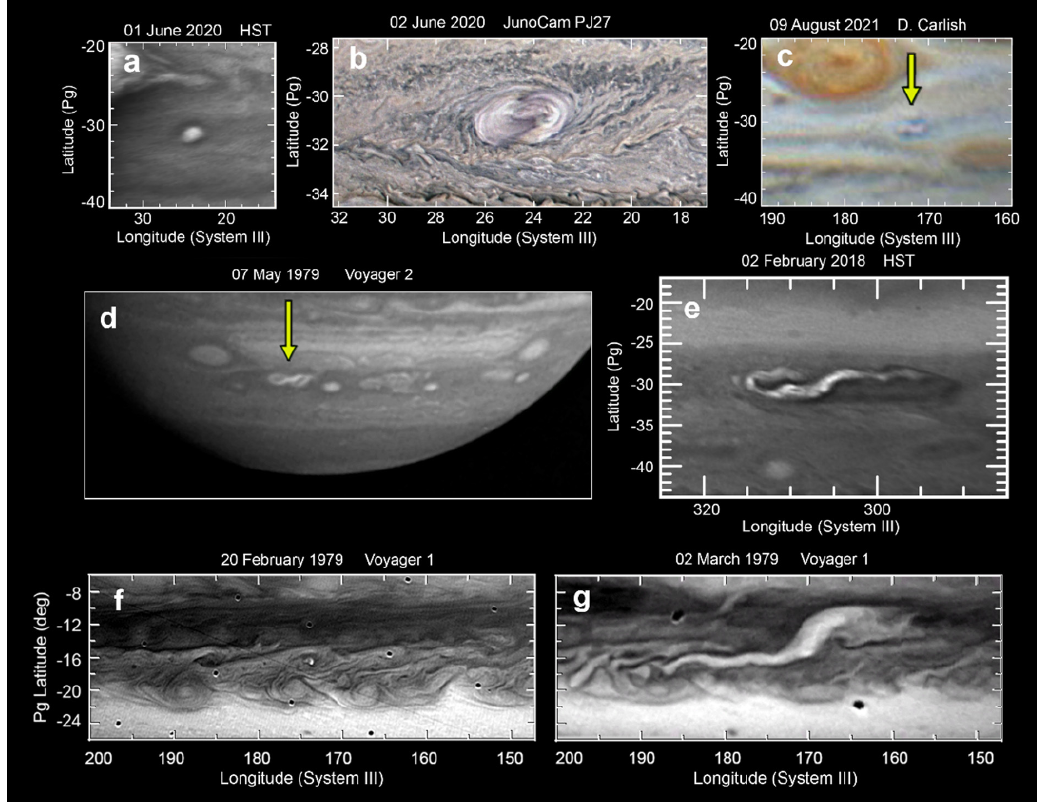
Figure 2. Storm systems which had a cyclonic origin (adapted from [35]). (Panels a − c ) correspond to the evolution of Clyde’s spot from an initial outbreak to a cyclonic FFR. (Panels d , e ) correspond to the STB Ghost. (Panels f , g ) correspond to a storm in the STB observed by Voyager